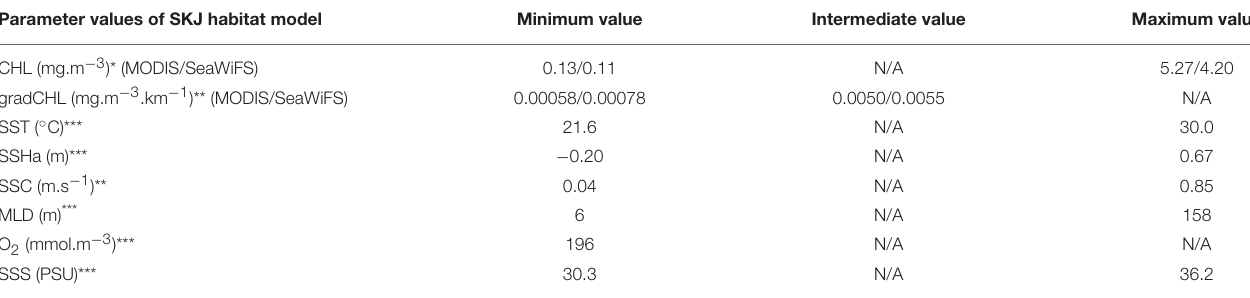
TABLE 1 | Model parameters used to define favorable feeding habitat for skipjack tuna ( Katsuwonus pelamis , SKJ) in the Eastern Central Atlantic and Western Indian Oceans (see also Figures SI-2, SI-3, SI-5) where SST (sea surface temperature), SSHa (sea surface height anomalies), SSC (sea surface current intensity), MLD (mixed layer depth), O 2 (sea surface dissolved oxygen), and SSS (sea surface